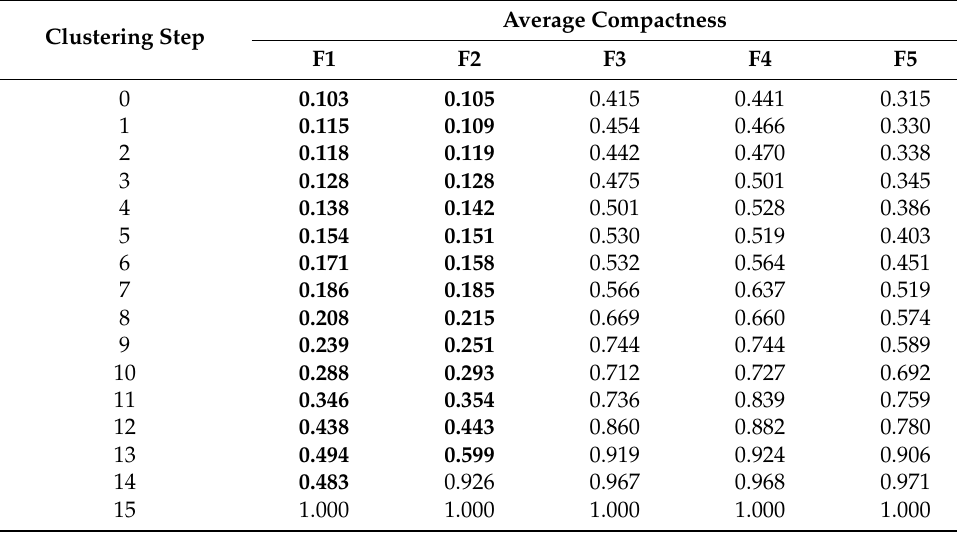
Table 4. Average compactness of each feature in each clustering step.